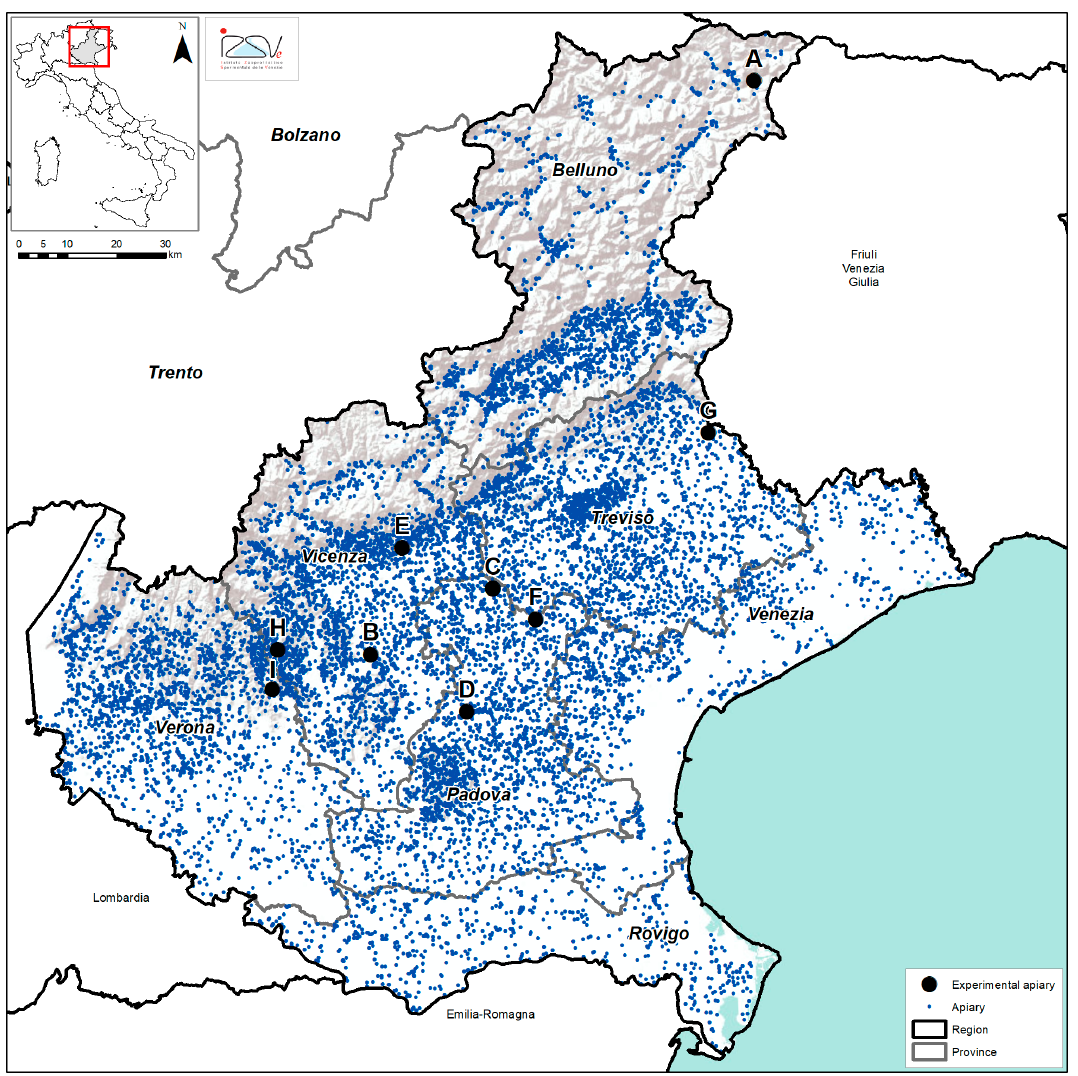
Figure 1. Veneto region (northeast of Italy): distribution of apiaries in the regional territory according to the Italian National Beekeeping Registry and location of the apiaries involved in the study (letter from A to I).